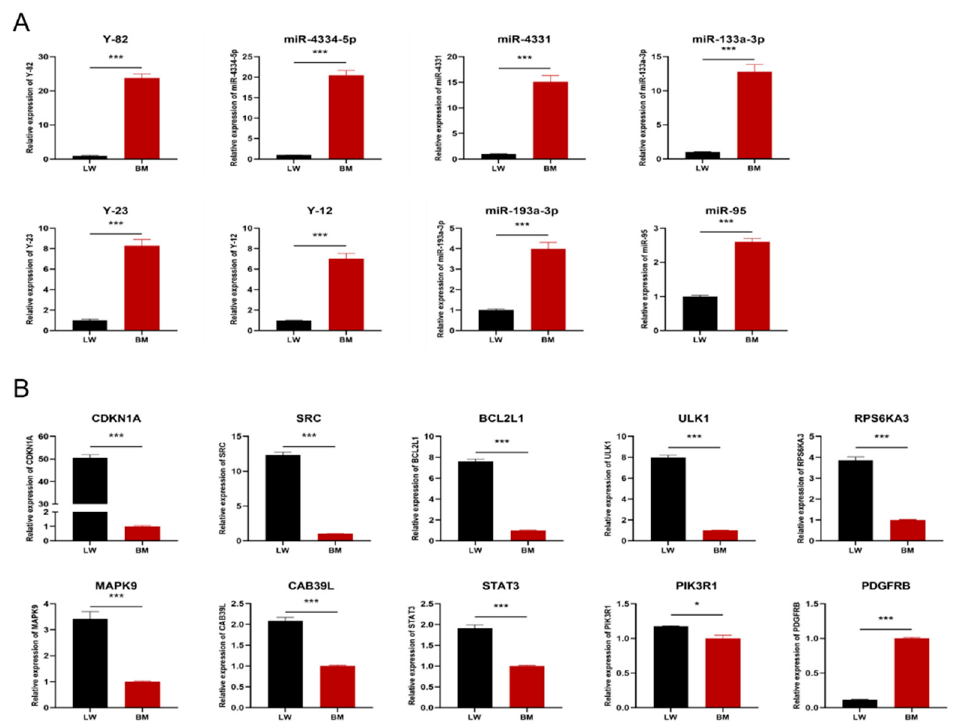
Figure 5. Expression levels of miRNA and mRNA in the pituitary cells of Landrace pigs and Bama minipigs. ( A ) Eight differentially expressed miRNAs. The expression abundance of Landrace pig (LW) was normalized to 1. ( B ) Ten differentially expressed mRNAs. The expression abundance of Bama minipig (BM) was normalized to 1. (* p < 0.05, *** p < 0.001.)